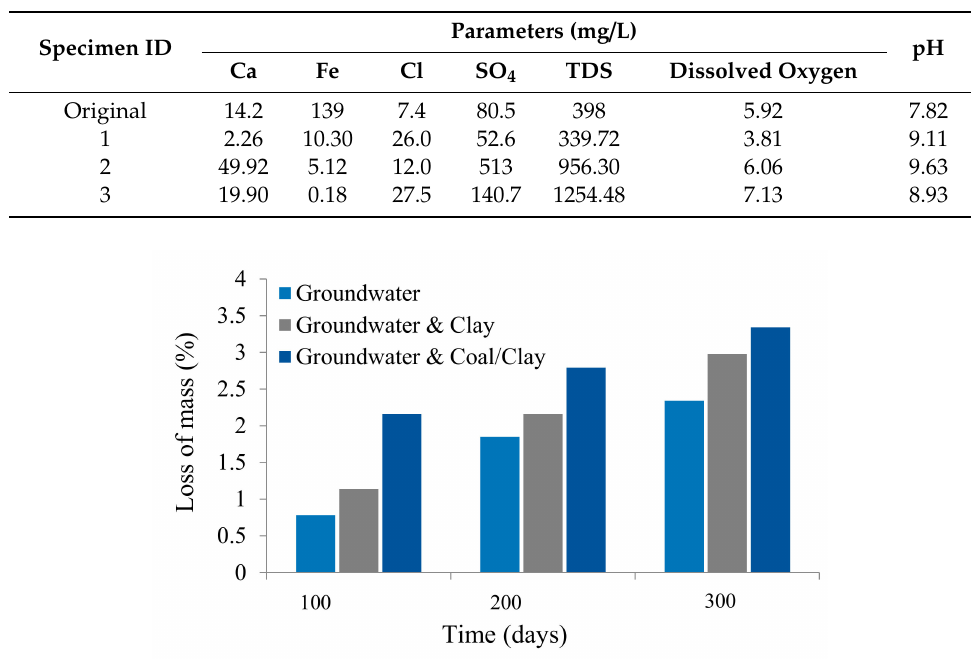
Table 6. The chemistry of the original groundwater and water samples after 300 days.